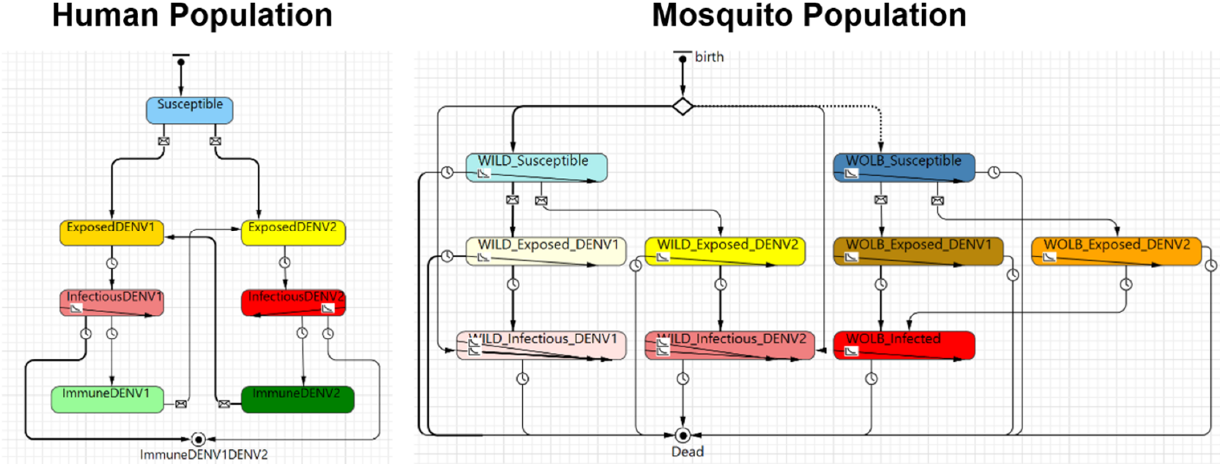
Figure 4. Snapshot of the simulation Model D (multi-strain, multi-vector dengue spread model).